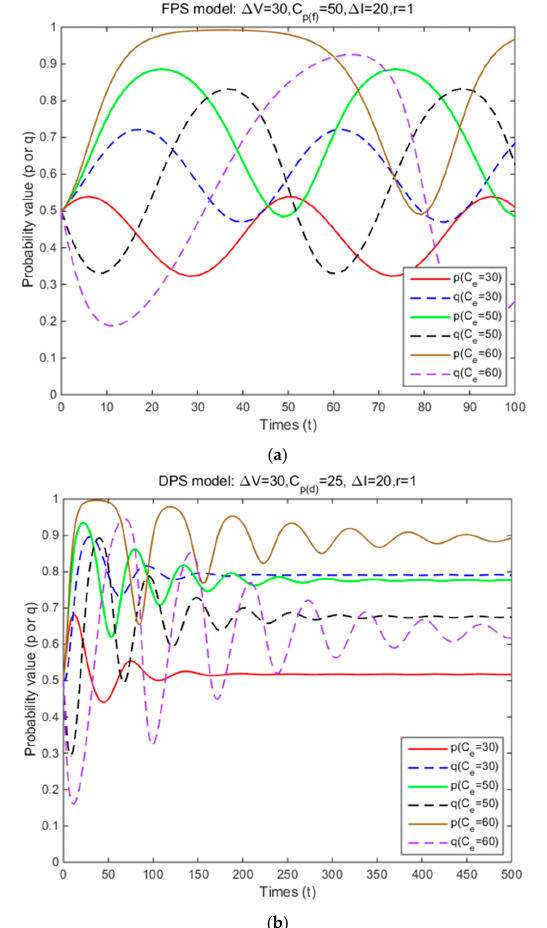
Figure 9. The effects of enforcement cost on strategy probabilities of cyclists and law enforcement under FPS ( a ) and DPS ( b ) (Situation 3).